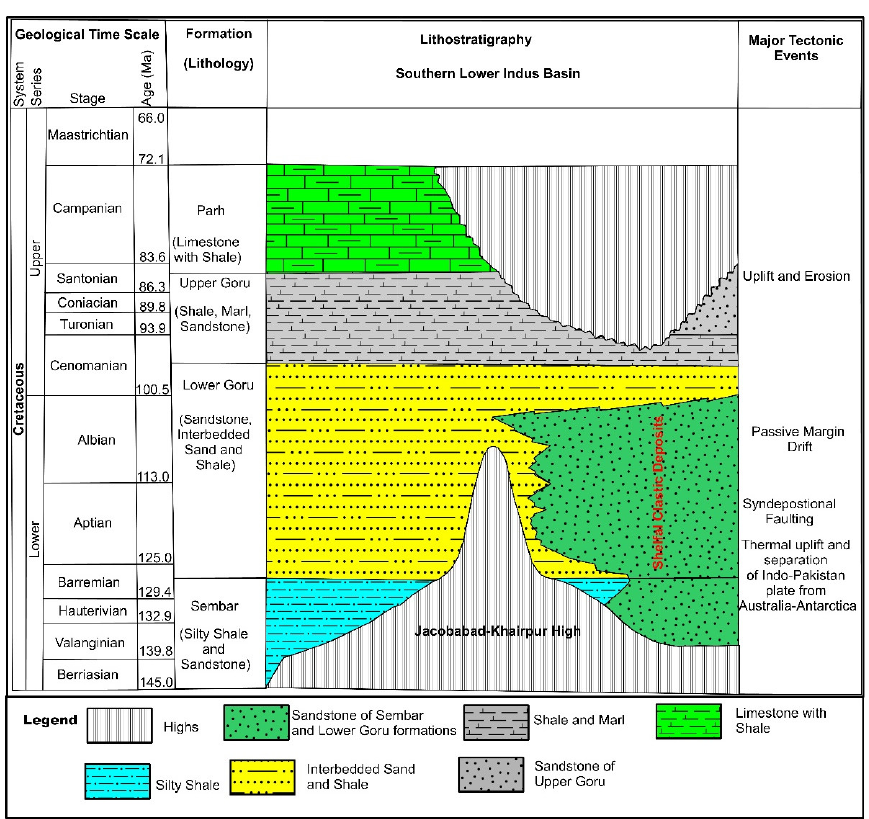
Figure 2. Stratigraphic chart of the Lower Indus Basin.